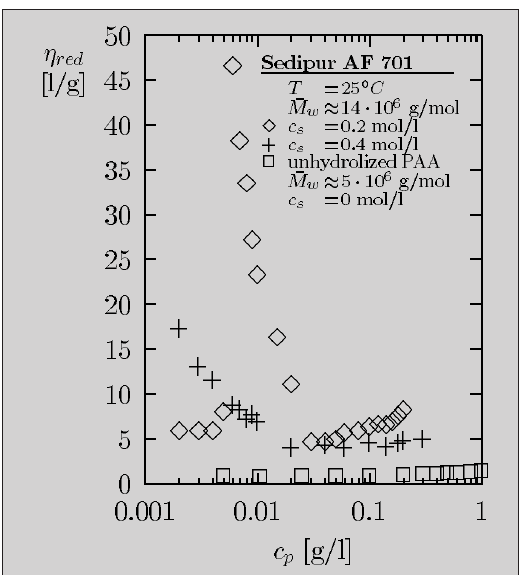
Figure 5: The reduced viscosity as a function of the polymer concentrations for different polymer solvent systems.